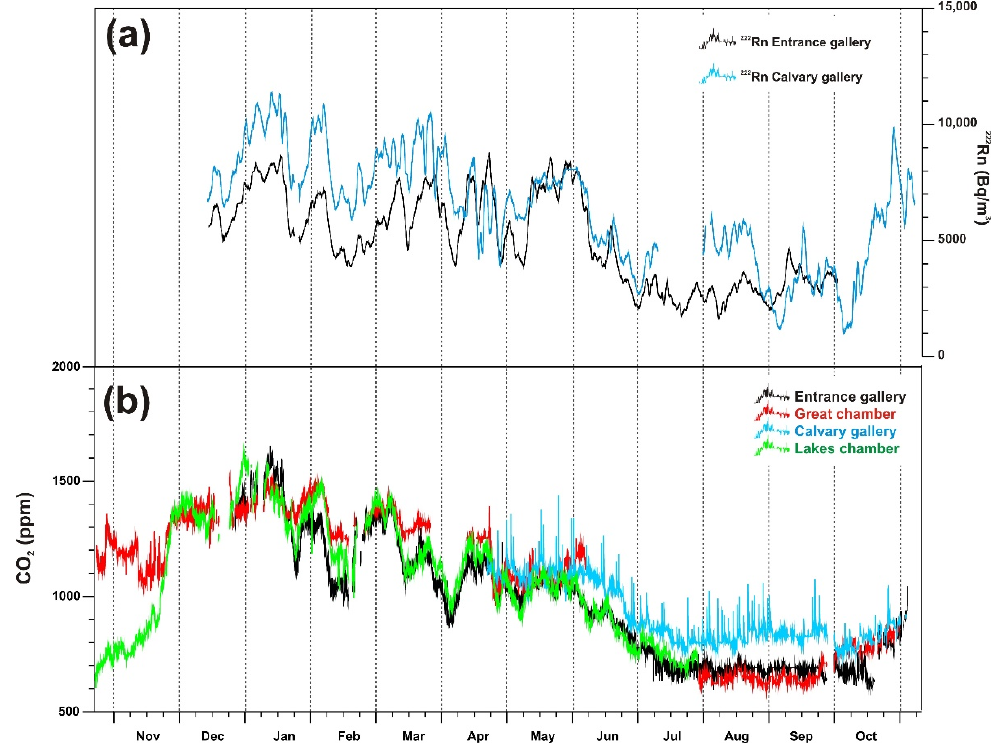
Figure 4. ( a ) Time series of Radon levels ( 222 Rn) and ( b ) CO 2 concentration of cave air at each monitoring station.